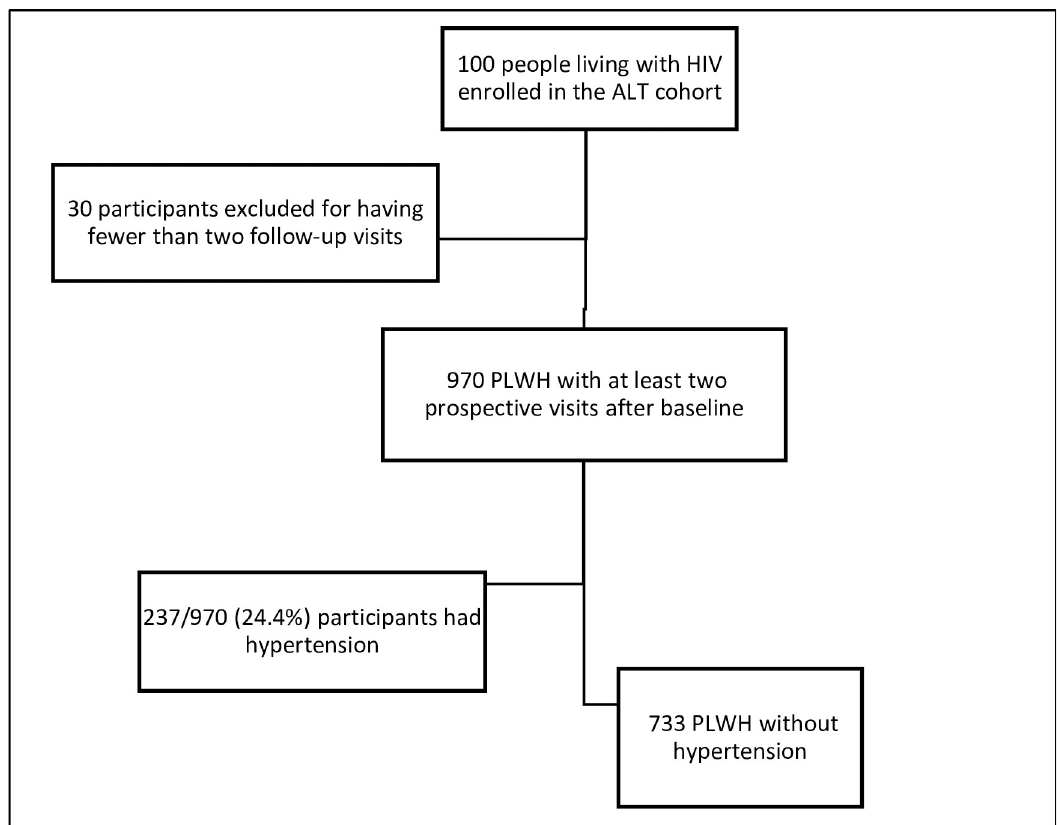
Fig 1. Participant inclusion for hypertension and weight gain